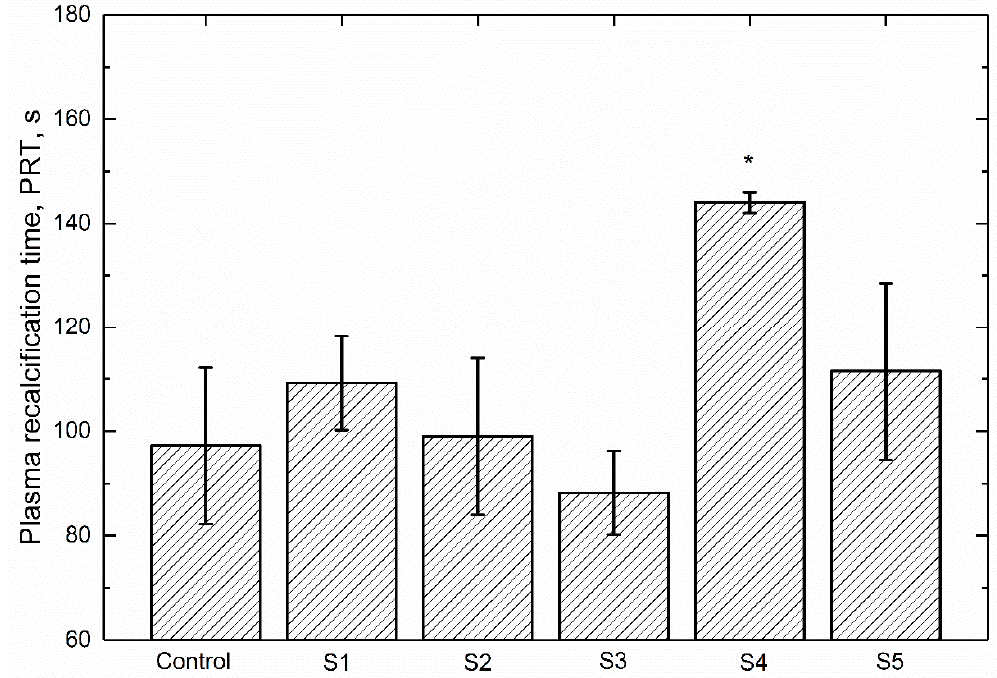
Figure 5. Plasma recalcification time of different samples (N = 4, * p < 0.05, statistically significant difference; Control vs. S1 to S5).